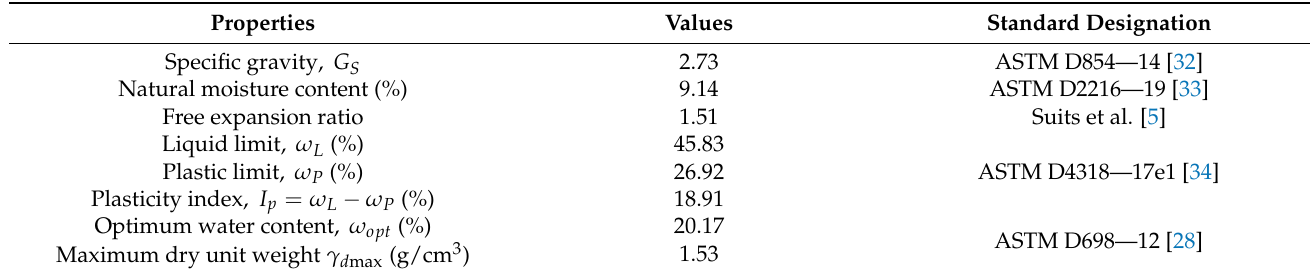
Figure 2. Slope preparation process. (( a ) layered compaction; ( b ) surface scraping; ( c ) dismantling mold; ( d ) slope cutting). Table 1. Physical properties of the selected expansive